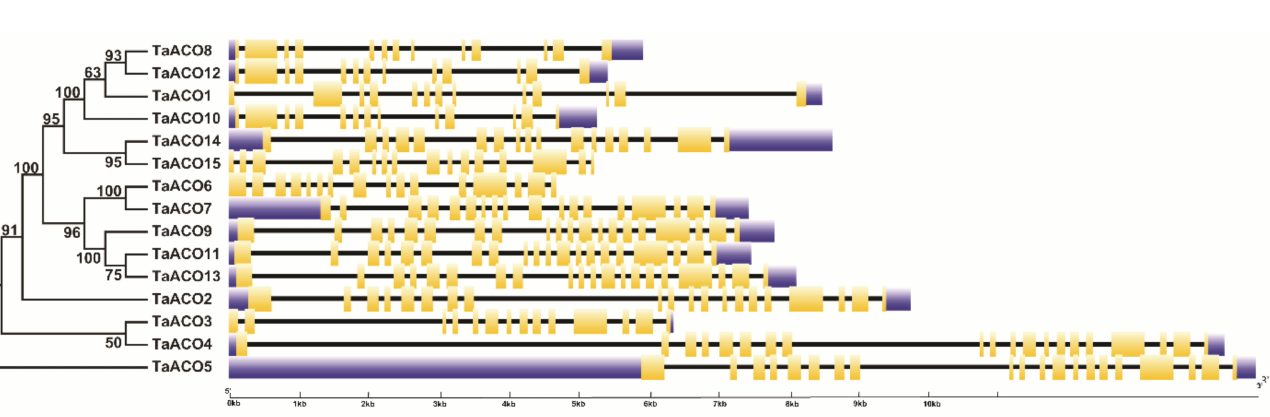
Figure 5. Gene structure organization of the TaACO genes. Blue boxes indicate the untranslated regions, yellow boxes denote the exons, and dark black lines signify the introns. The lengths of black lines and boxes are based on gene length.